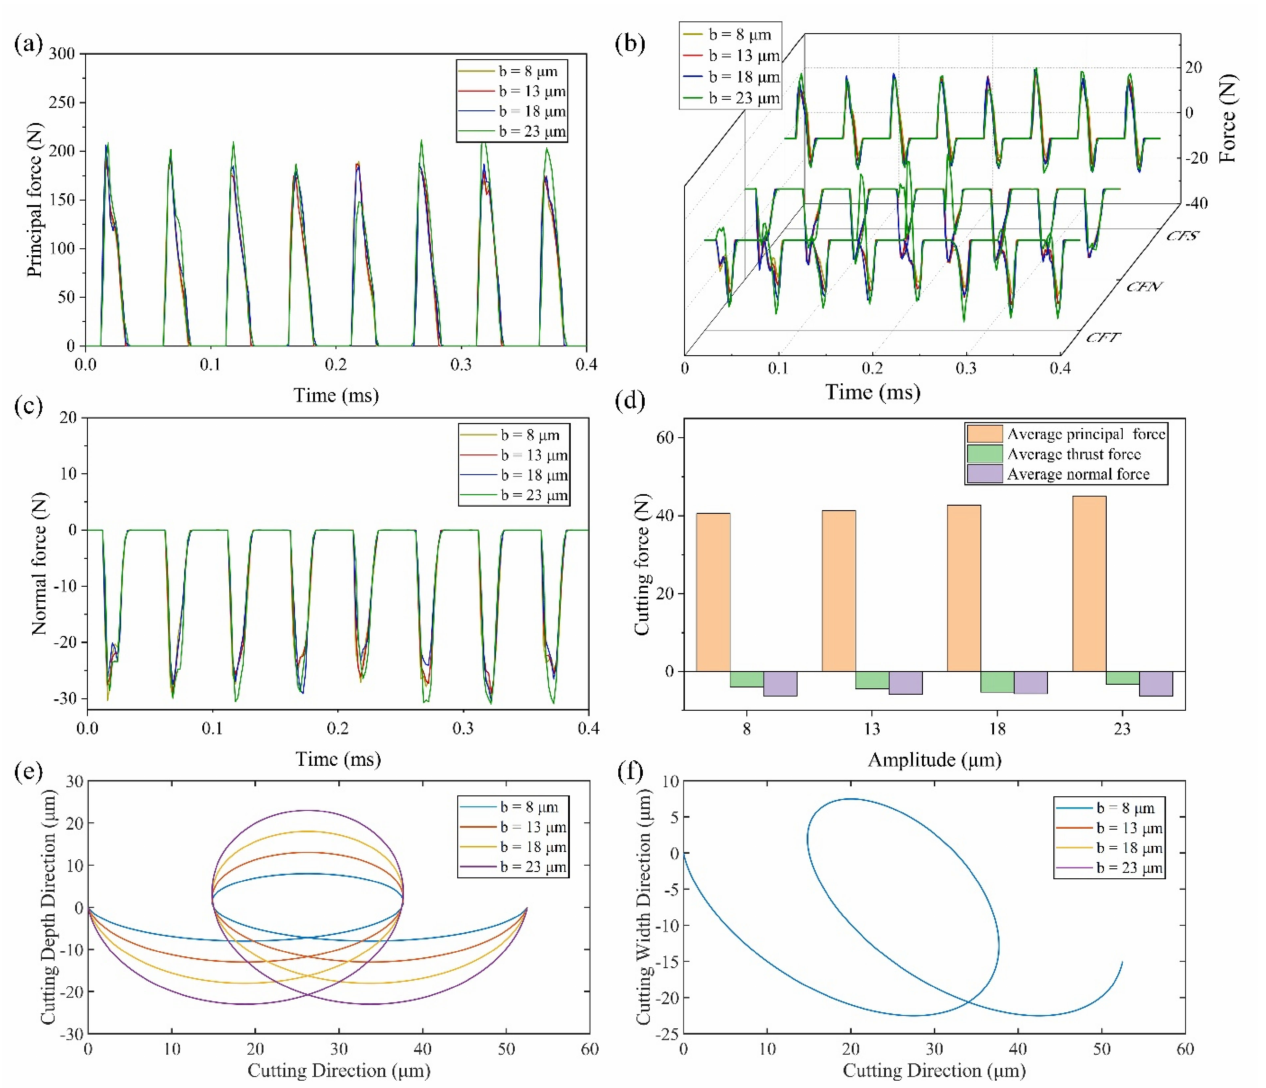
Figure 7. Results of cutting force and tool trajectories with various amplitudes b ( a ) principal force ( b ) thrust force ( c ) normal force ( d ) average cutting force ( e ) cutting trajectory with various amplitudes b in XoY plane ( f ) cutting trajectory with various amplitudes b in XoZ